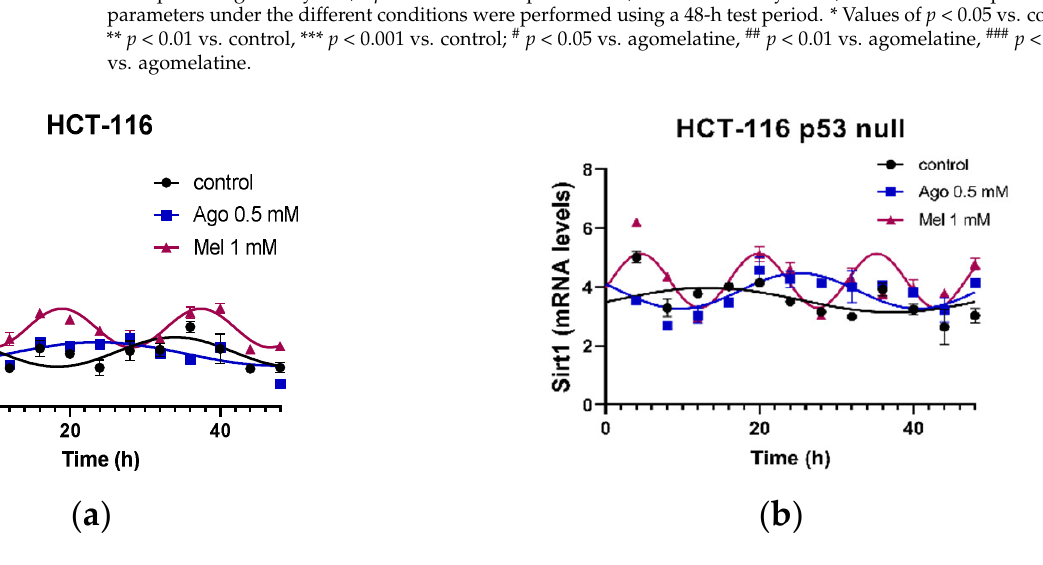
Figure 7. Characteristics of each of the rhythms obtained for sirtuin 1 (SIRT1) gene after agomelatine (Ago) and melatonin (Mel) treatments in the HCT-116 ( a ) and HCT-116-p53-null ( b ) cell lines. Curve fittings under the different conditions were performed using a 48-h test period. In order to find differences between the mechanisms of action of agomelatine and melatonin that could explain the differences in rhythmicity found between the genes studied in the two cell lines, we also analyzed the PRX1 in the non-treated cells and after the agomelatine and melatonin treatments (Figure 8). The PRX1 acrophase in the HCT-116 cells showed an advance in phase but lower MESOR than in the HCT-116-p53-null cells (Table 4). Agomelatine and melatonin induced changes in different parameters in the HCT-116 cells (Figure 8a). Melatonin induced an advance in phase in the acrophase and